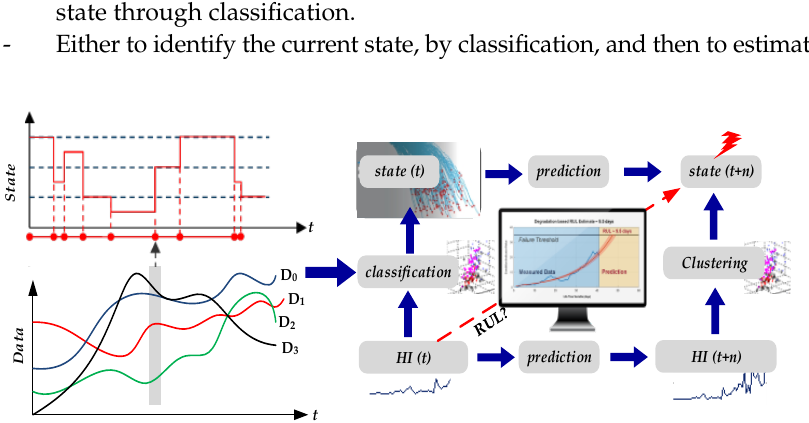
Figure 10. Prognosis processes: prediction and clustering. Table 1. Prognostics